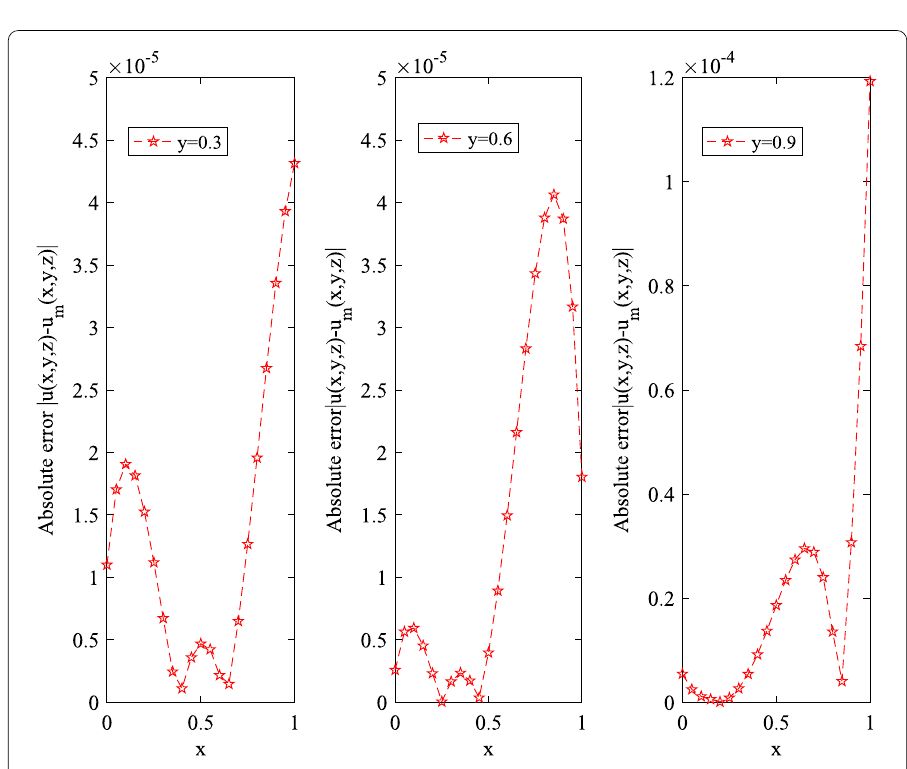
Figure 7 The absolute error with m = 64 at y = 0.3,0.6,0.9 for Example